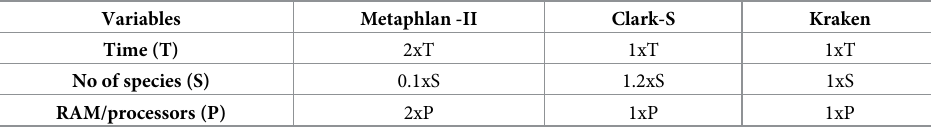
Table 3. Performance comparison of different